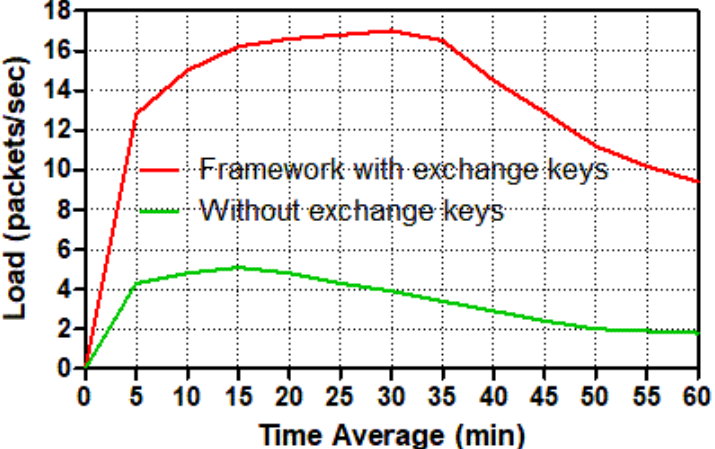
Figure 8. Queuing delay (s) from a smart meter to the switch for different tasks.